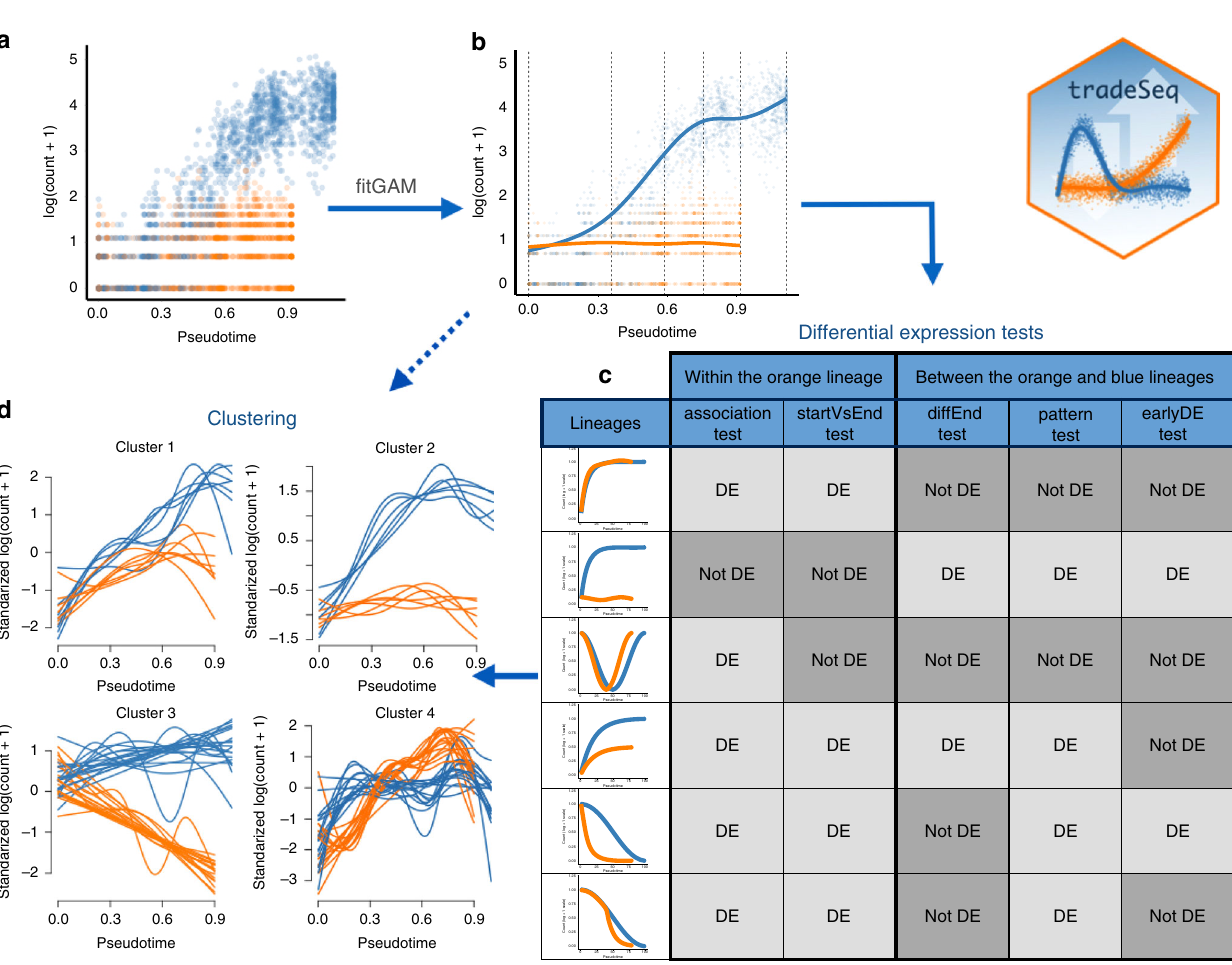
Fig. 1 Overview of tradeSeq functionality. a A scatterplot of expression measures vs. pseudotimes for a single gene, where each lineage is represented by a different color (top left). b A negative binomial generalized additive model (NB-GAM) is fi tted using the fi tGAM function. The locations of the knots for the splines are displayed with gray dashed vertical lines. c The NB-GAM can then be used to perform a variety of tests of differential expression within or between lineages. In the table, we assume that the earlyDETest is used to assess differences in expression patterns early on in the lineage, e.g., with option knots = c(1, 2) , meaning that we test for differential patterns between the fi rst and second dashed gray lines from panel ( b ). d Interesting genes can fi nally be clustered to display the different patterns of